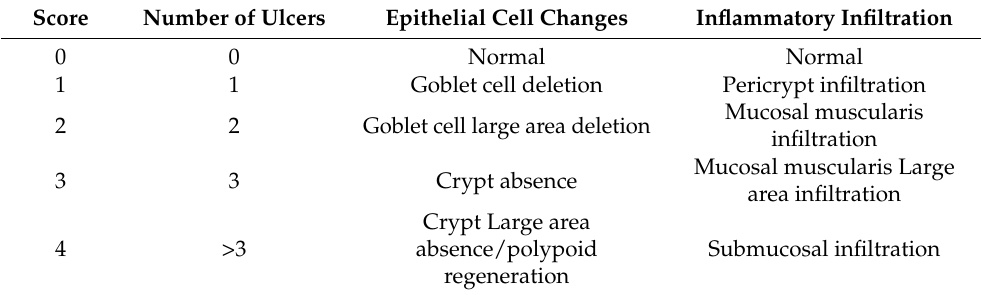
Table 2. Scoring criteria for histological